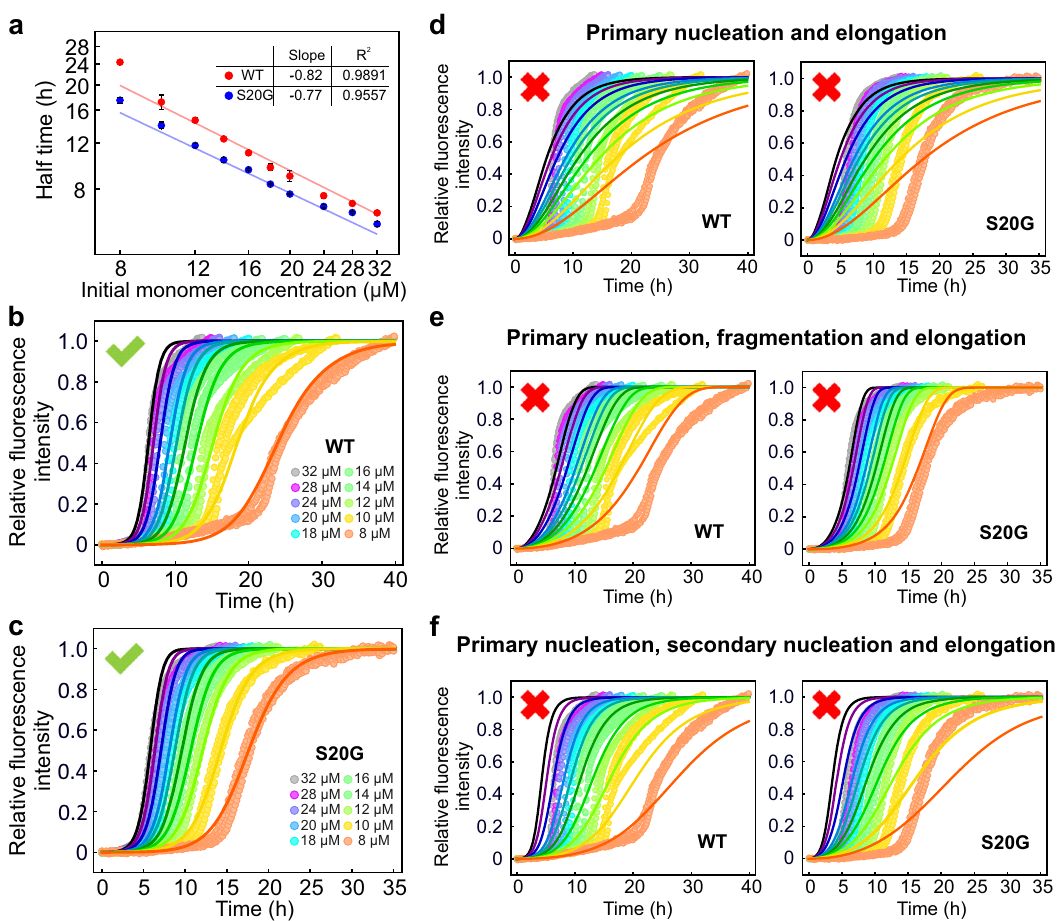
Fig. 2 Global fi tting of wt hIAPP and S20G aggregation kinetics to different kinetic models. a Double logarithmic plots of the half time of aggregation (t 50 ) versus monomer concentration for wt hIAPP (red) and S20G (blue). The solid line is the fi t of a power function (t 50 ~Am 0 γ ). The inset shows the average scaling exponent for wt hIAPP and S20G. Results are mean ± SD of n = 3. b , c Aggregation kinetics of wt hIAPP and S20G monitored by ThT fl uorescence. Experimental data are shown as circles. The experiment at each concentration was performed in triplicate (shown in the same colour). The best global fi t including primary nucleation, elongation and multi-step secondary nucleation is shown in lines. The model used for the global fi tting includes three variable parameters: the combined rate constants k + k n and k + k 2 and Michaelis constant K M for secondary nucleation. The reaction orders for primary (n c ) and secondary nucleation (n 2 ) were fi xed to 2. Models containing primary nucleation and elongation ( d ); primary nucleation, elongation and fragmentation ( e ); and primary nucleation, elongation and secondary nucleation ( f ) each fail to achieve a satisfactory global fi t for wt hIAPP and experimental data and various reaction orders for primary nucleation (n c ) and secondary nucleation (n 2 ) were also tried.